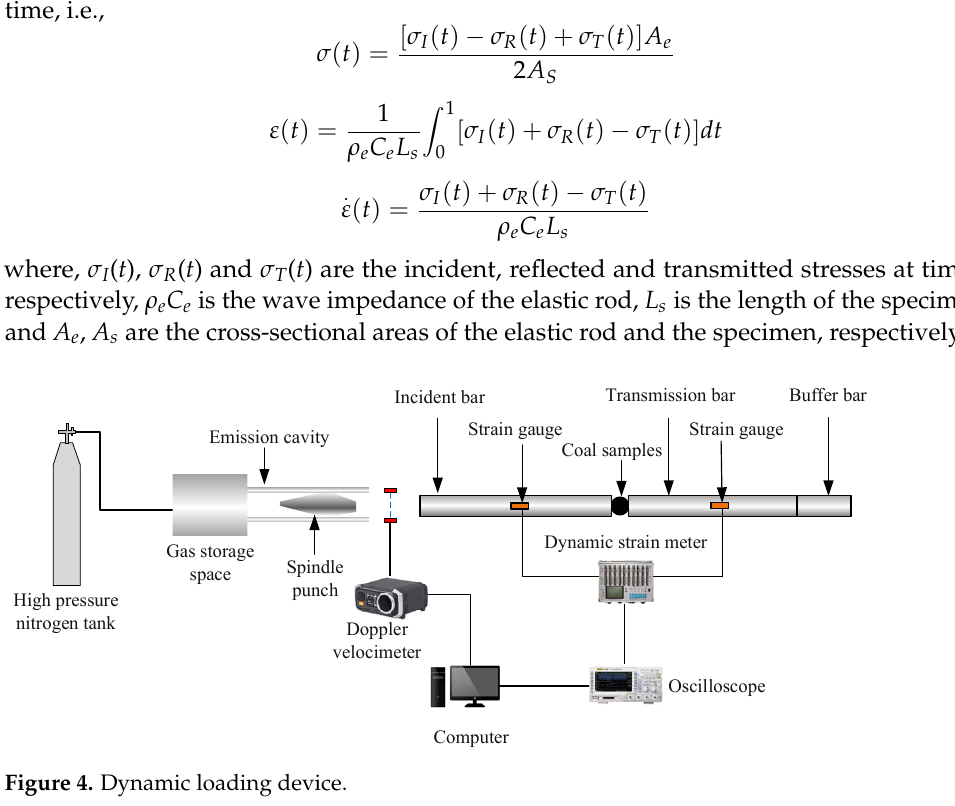
Figure 4. Dynamic loading device.